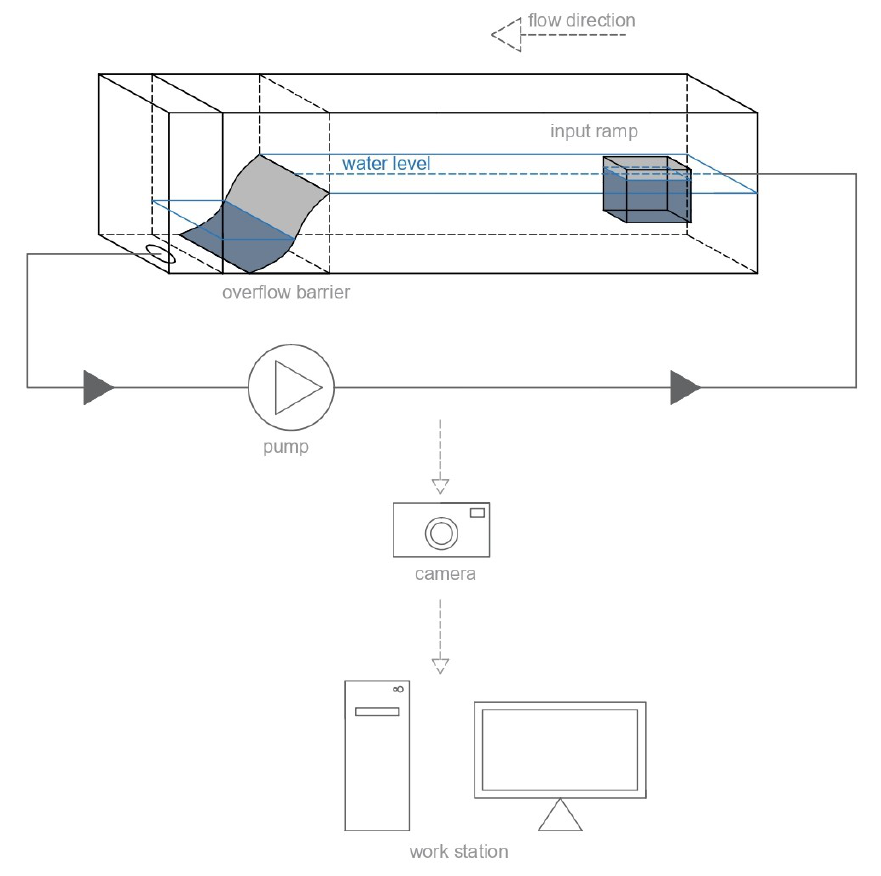
Figure 3. Schematic representation of the experimental tool used.